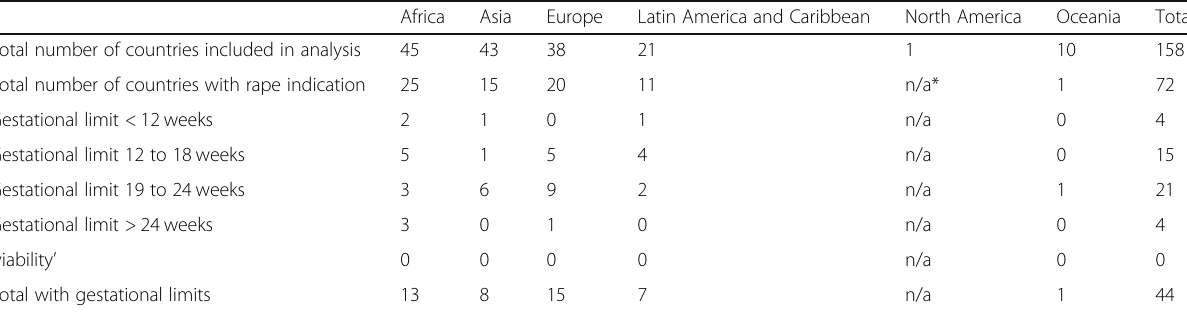
Table 4 Regional data: Rape ground and associated gestational limits